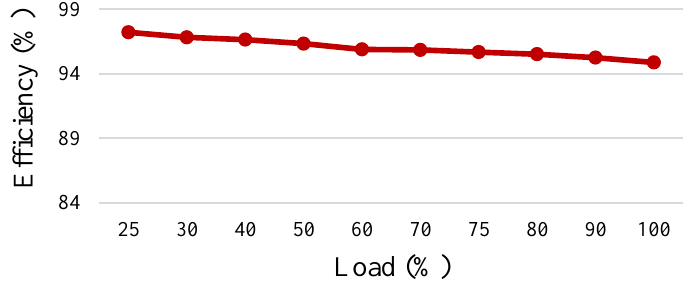
Figure 25. Curves of Efficiency against load.